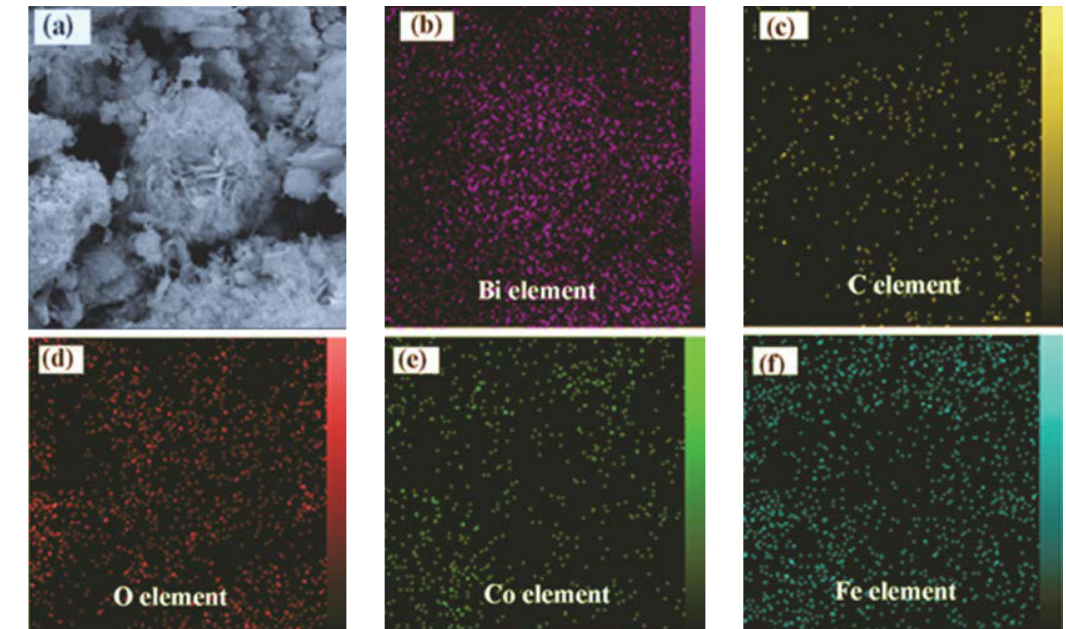
Figure 6. SEM image and the corresponding elemental mapping images of Bi 2 O 2 CO 3 /CoFe 2 O 4 30%.